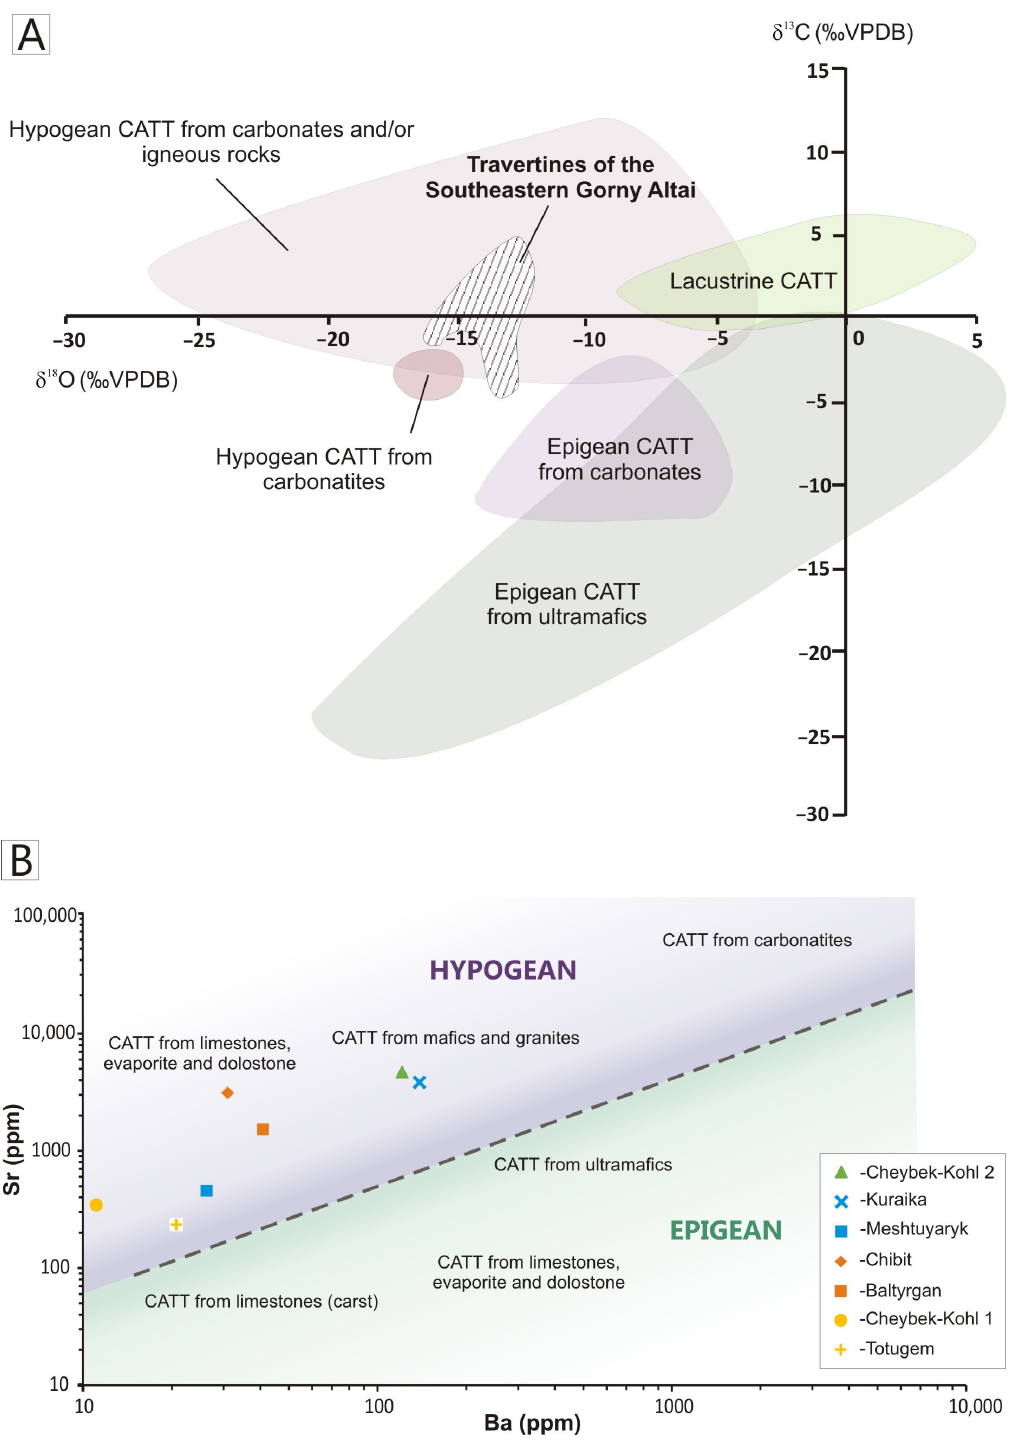
Figure 16. δ 13 C- δ 18 O ( A ) and Sr-Ba ( B ) cross-plots of travertines from the south-eastern Gorny Altai overlain on clusters of Teboul et al. [16].